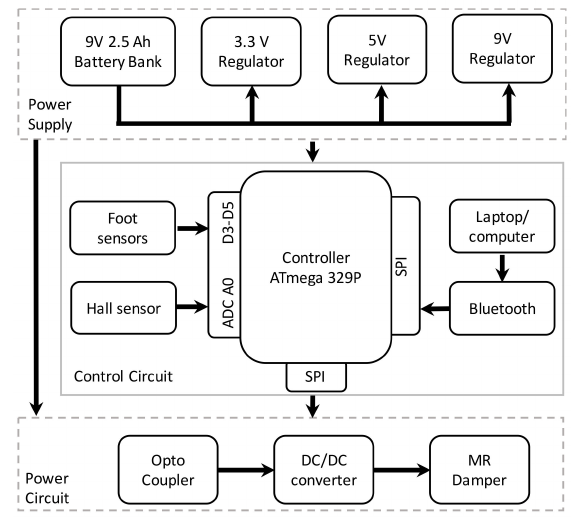
Figure 4. Embedded system